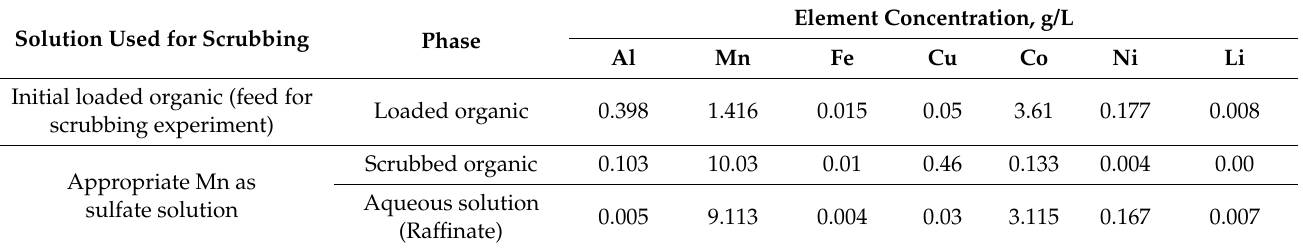
Table 3. Representative data of composition of organic/aqueous phases of scrubbing